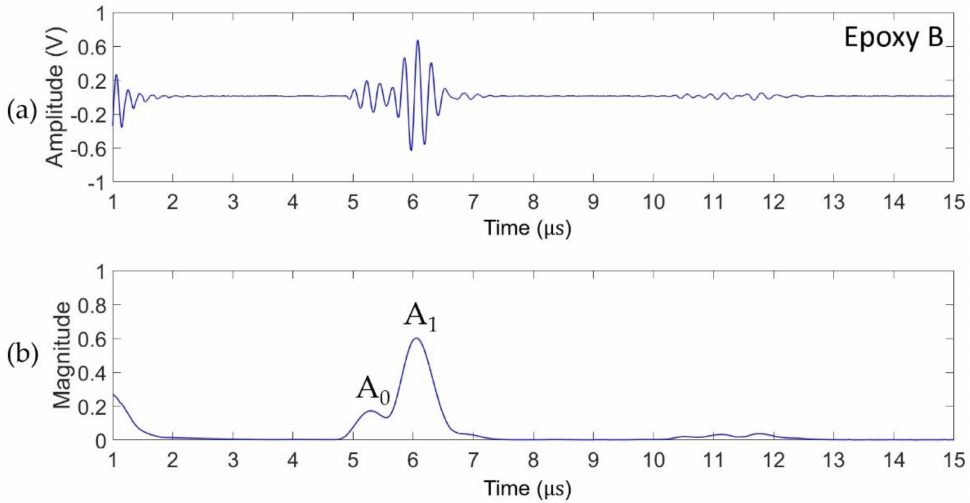
Figure 7. Epoxy B coating (thickness less than 1 mm): ( a ) time-domain waveform and ( b ) the projection of the STFT.